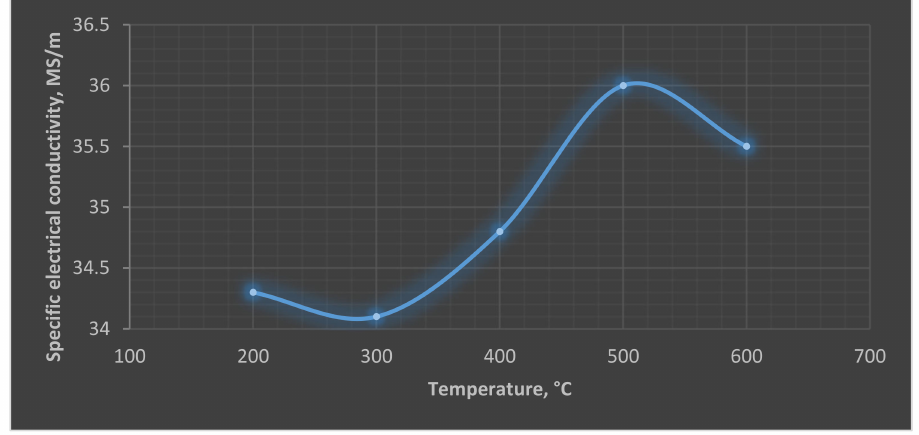
Figure 5. The dependence of electroconductivity from spraying temperature of 40%Cu-60%Al 2 O 3